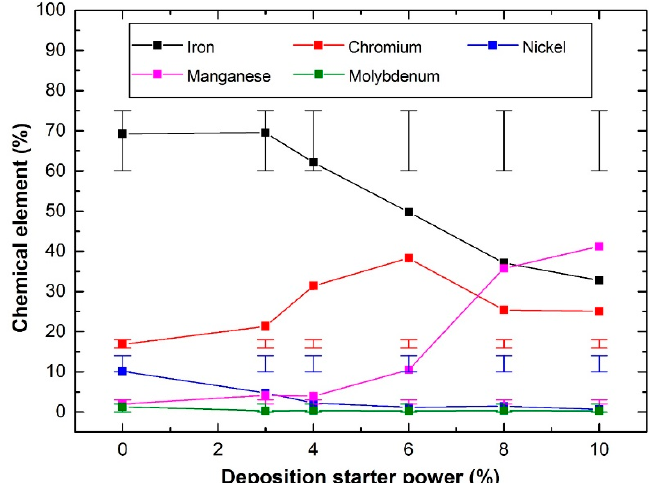
Figure 4. EDS characterisation of the chemical elemental percentages of the evaporant source (0% power), and the SS thin films deposited with a starting beam power of 3% up to 10%. The bars at the top and bottom of each data point indicate the maximum and minimum range of each element percentage of the stainless steel 316L composition and was attained from the XRF device installed database.